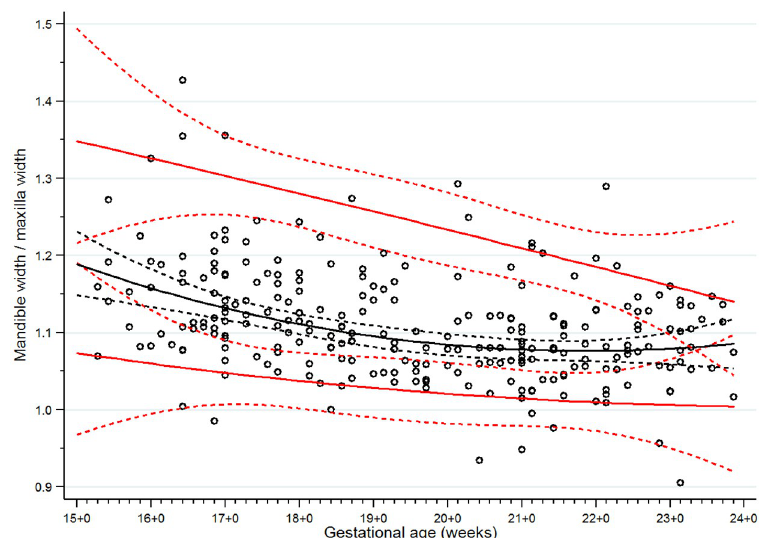
Fig 8. Scatter plot of mandible width/ maxilla width (MD/MX ratio) along gestational age. Solid lines represent the MD/MX ratio values in the 5th, 50th and 95th percentiles, Dashed lines represent the 95% confidence interval for each given